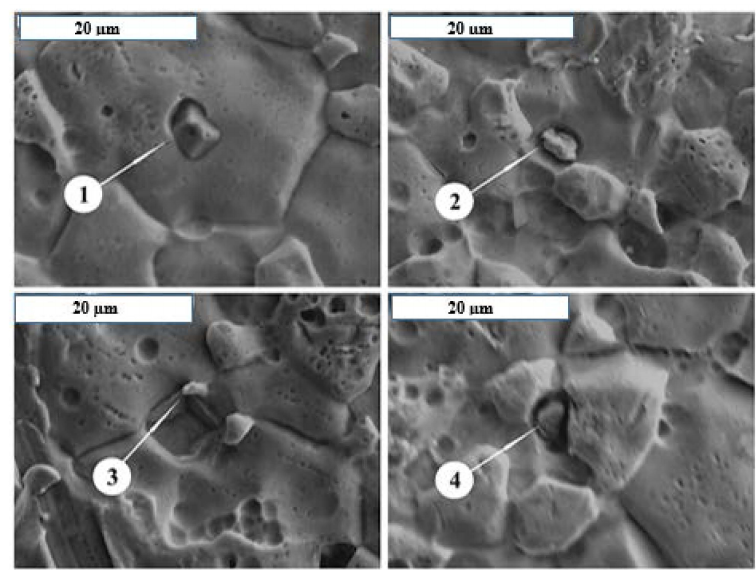
Figure 5. SEM of the microconstituents formed during LSP at 1064 nm, E = 10 mJ, and number of accumulated pulses: ( a ) 100; ( b ) 100; ( c ) 50 and ( d ) 50. Power density: 3.3 GW/cm 2 .